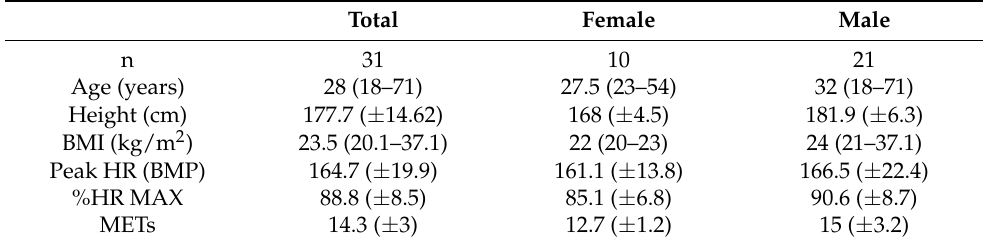
Table 2. Participants’ characteristics and stress test results. Total